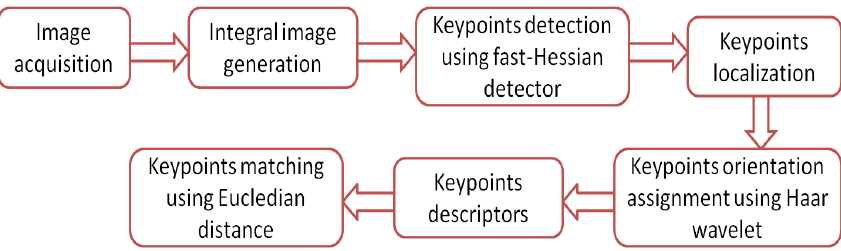
Figure 9. Flow chart for the SURF